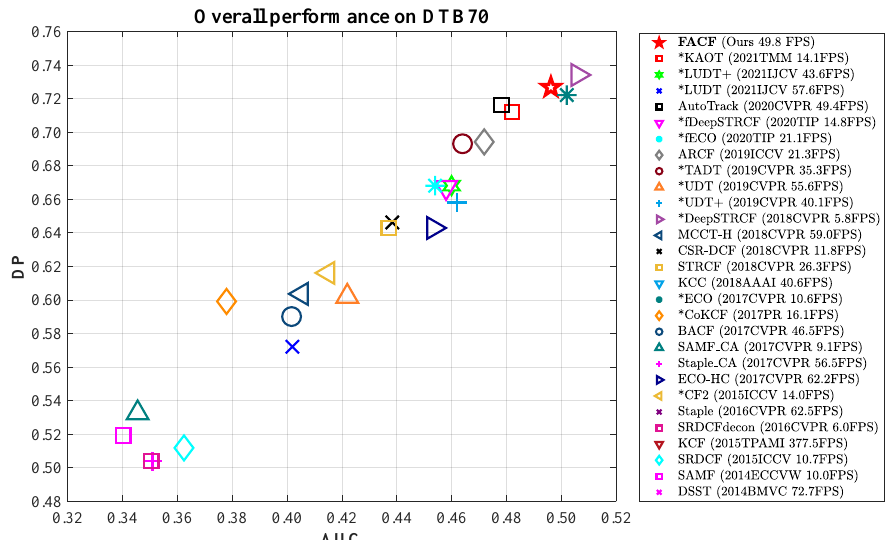
Figure 1. Overall performance based on area under curve (AUC) and distance precision (DP) between the proposed FACF tracker and 29 other state-of-the-art trackers on DTB70 [25] benchmark. AUC and DP are two metrics for evaluating tracking accuracy for which its detailed explanation is in Section 5. The legend provides detailed speed values of each tracker. The superscript ∗ represents the GPU-based